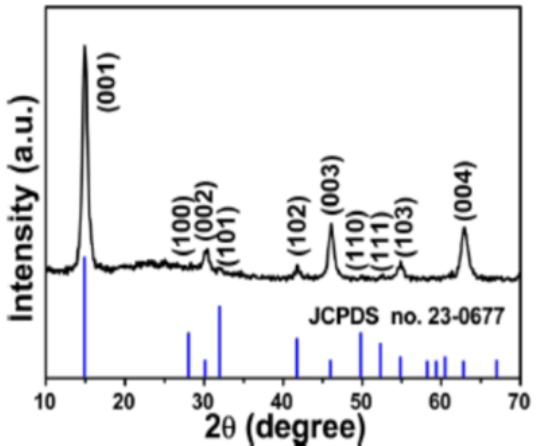
Figure 13. XRD pattern of SnS 2 nanosheets (NSs) prepared at 220 °C for 12 h. Reproduced with permission from [38].